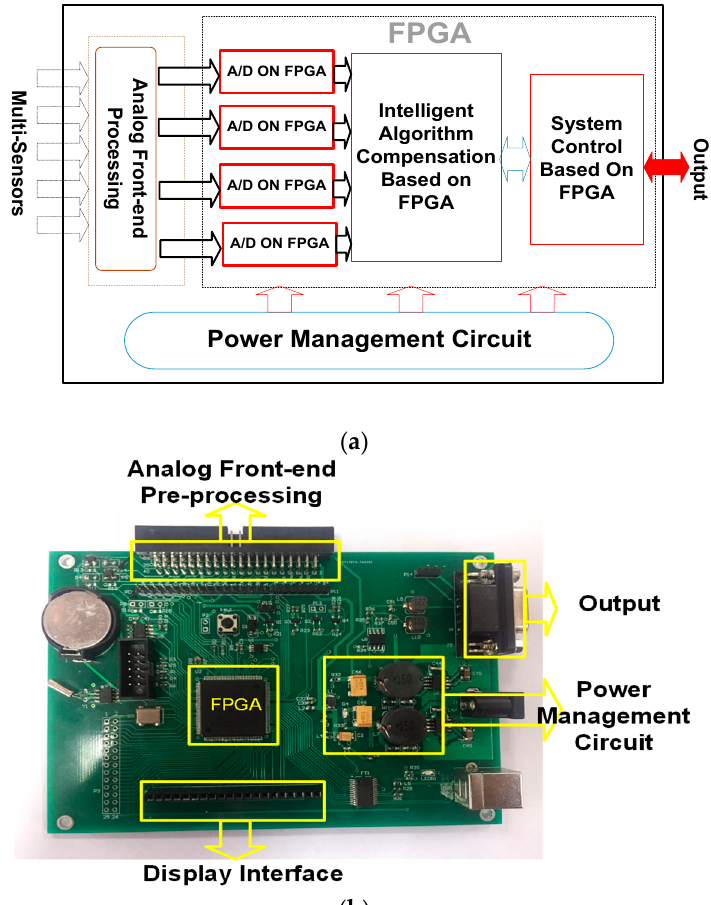
Figure 4. ( a ) Diagram of the circuit system framework of the mixed natural gas online testing system, in which the FPGA is the core of the intelligent algorithm and control module; ( b ) Processing circuit, in which the FPGA plays an important role. The FPGA is used to implement the NN algorithm and system control.